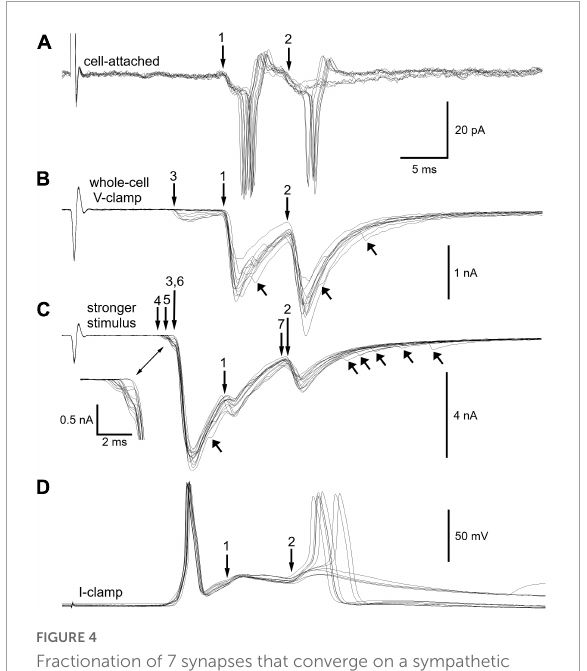
FIGURE4 Fractionation of 7 synapses that converge on a sympathetic neuron. (A) Additional extracellular on-cell recordings from the same neuron illustrated in Figure 3 . (B) Intracellular voltage-clamp recordings of synaptic currents after breaking into the cell. Presynaptic stimulus strength unchanged from panel (A) . The records show families of excitatory postsynaptic currents (EPSCs) whose latencies match those of responses 1 and 2 in panel (A) . The smaller EPSCs at synapse 3 were not detected in the on-cell recording. Upward arrows point to examples of asynchronous EPSCs present in some trials. (C) After increasing the presynaptic stimulus strength, a total of 7 synaptic components were resolved based on the latencies and magnitudes of EPSCs. Inset shows the small EPSCs at the foot of the large EPSCs associated with synapse 6. Upward arrows point to additional asynchronous EPSCs. (D) Switching the amplifier to current-clamp mode reveals EPSPs that drive pairs of action potentials. Note that the larger synaptic events (6, 1, 2) obscure the smaller ones. Note also that the double spiking differs